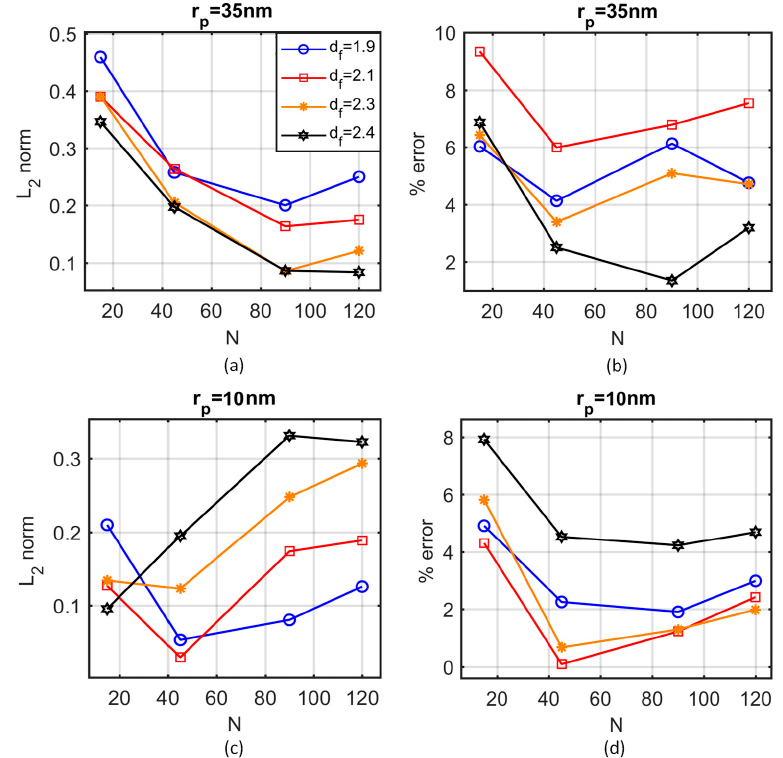
Figure 6. Error in L 2 norm of the autocorrelation function ( a , c ) and the percentage error in the areal porosity ( b , d ) as functions of the average number of particles per aggregate, for di ff erent values of the fractal dimension, for r p = 35 nm ( a , b ) and r p = 10 nm ( c , d